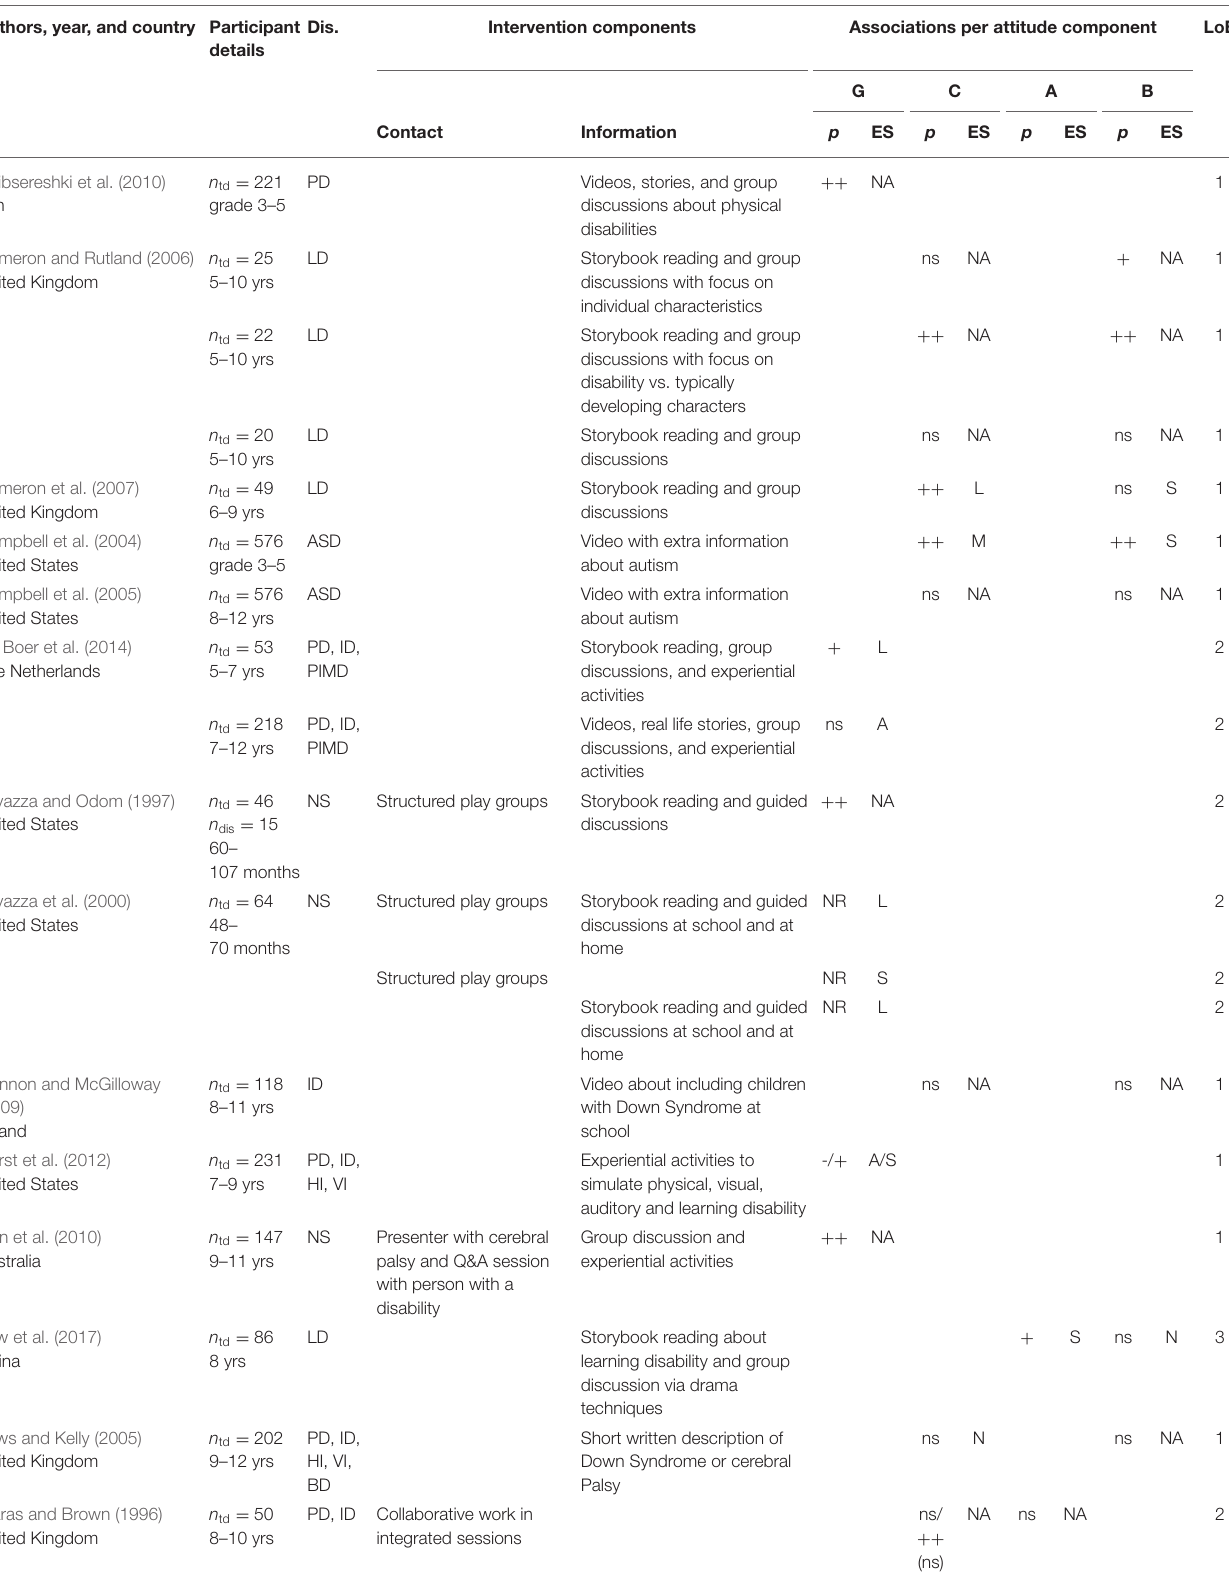
TABLE 3 | Summary of studies and interventions focusing on promoting the attitudes of typically developing peers. Authors, year, and country Participant